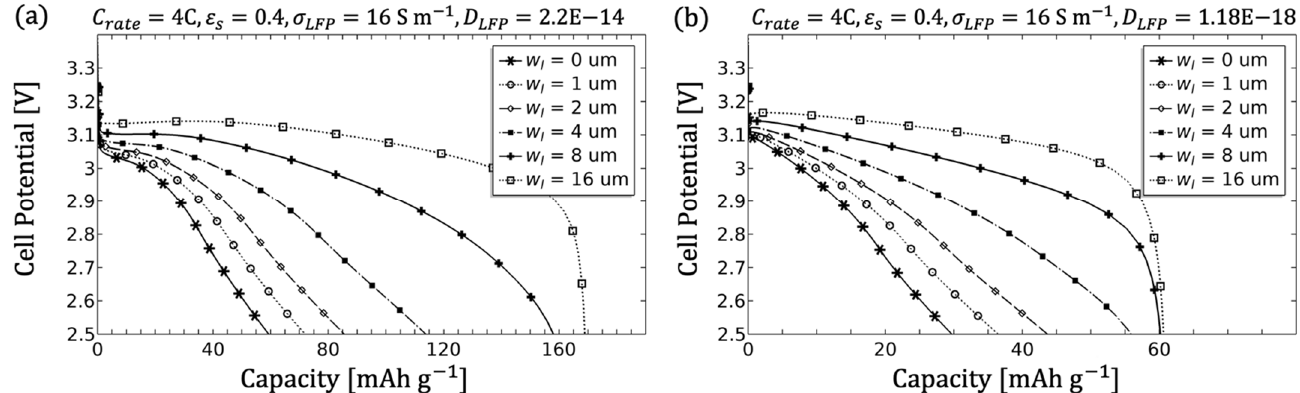
Figure 13. Simulation of a macrostructure with an additional transport channel with an adjustable width w l and τ = 1; ( a ) shows the discharge performance at 4C with D LFP = 2.2 × 10 − 14 and in ( b ) with D LFP = 1.18 × 10 − 18 at 4C.